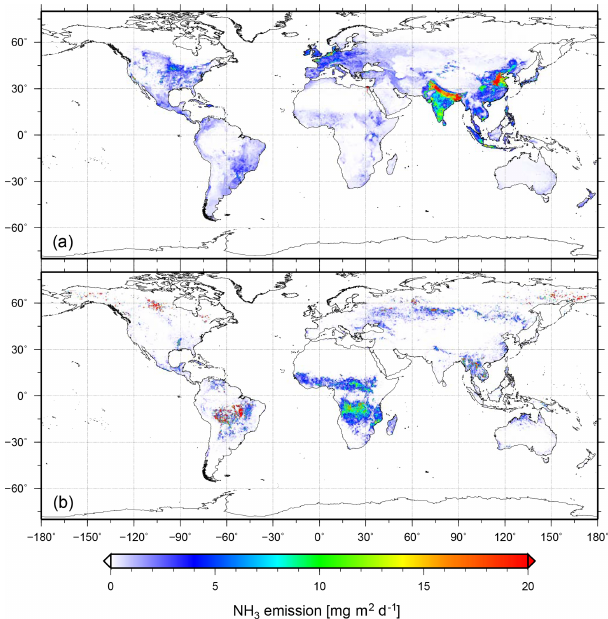
Figure 6. Anthropogenic ammonia emissions in 2010 obtained from EDGAR-HTAP v2 (a) and the biomass burning emissions from GFED4.1s (b)